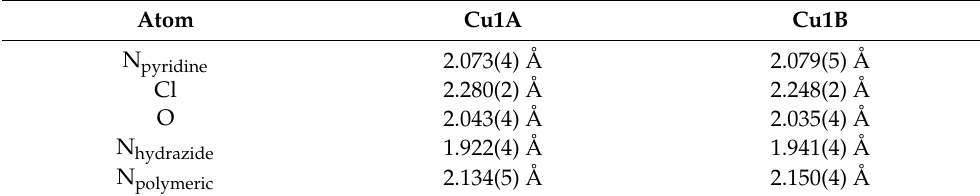
Figure 3. Coordination polyhedron around Cu 2+ ion in the 1 ∞ { [ Cu L Cl ] · 0.5H 2 O }